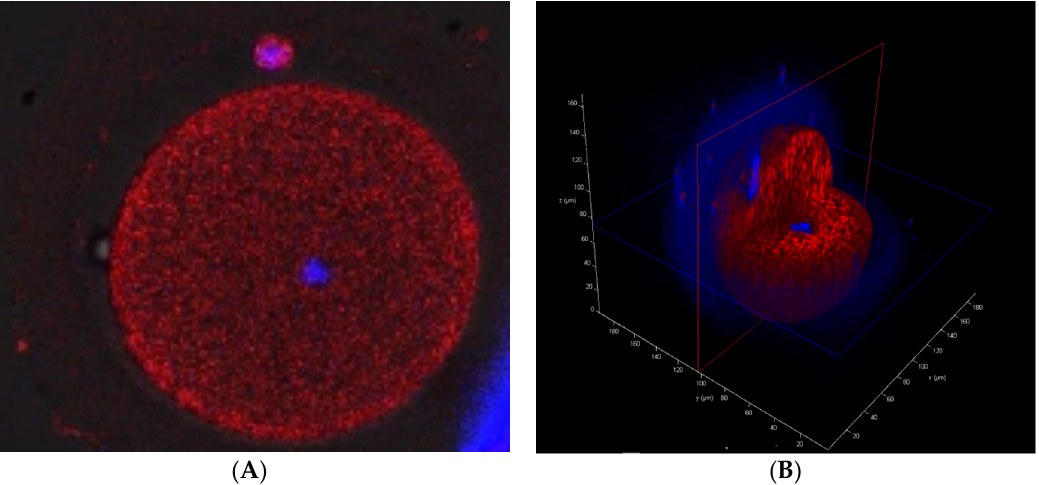
Figure 4. ( A )—the MitoTracker Red CMXRos (Invitrogen, Ipswich, MA, USA)-stained MII oocyte. Mitochondria are stained red, nuclei are stained blue. ( B )—the oocyte in the 3D cross-section.